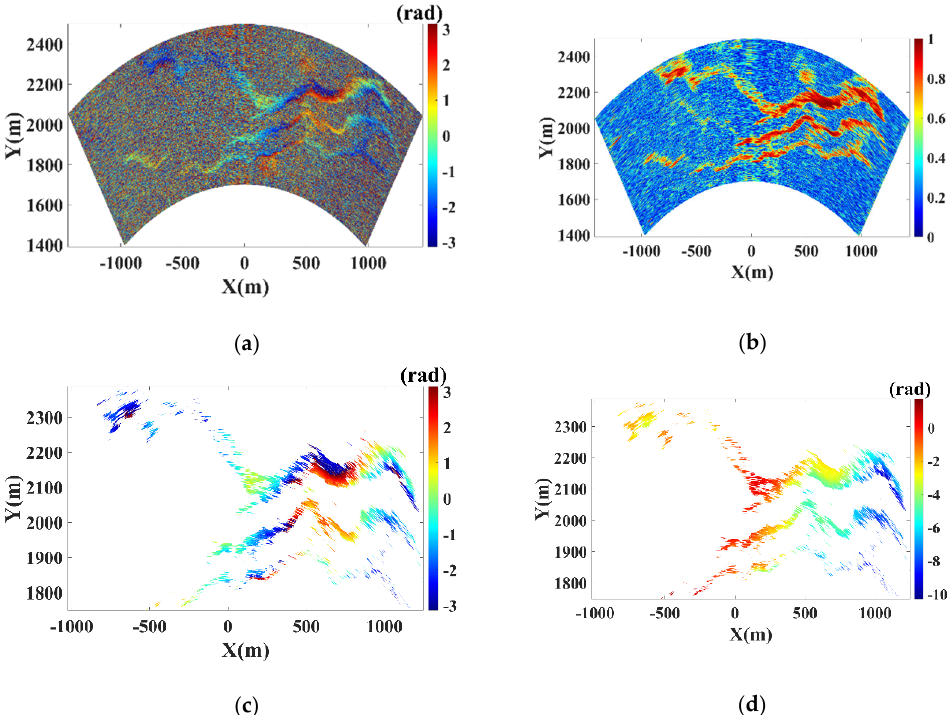
Figure 14. Results of PS selection: ( a ) Interferometric phase map; ( b ) Coherence map; ( c ) Wrapped phases of PSs; ( d ) Unwrapped phases of PSs.